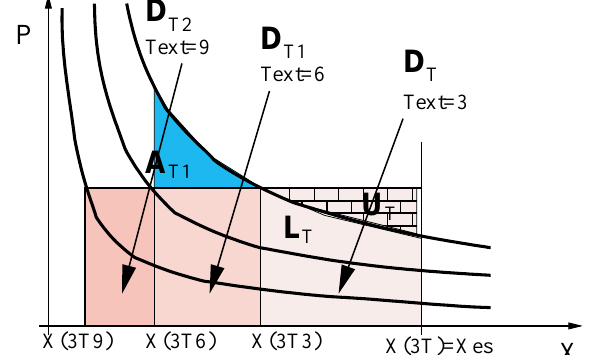
FIG. 5. (Color) Sketch, in the normal coordinates frame, of the extracted emittance for a rectangular set of initial conditions and T (cid:1) 3